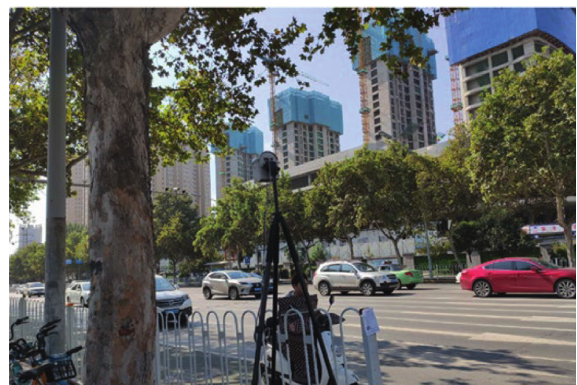
Figure 5: The radar survey at the intersection. This figure was taken at 34.2174 ° N, 108.9125 ° E. The figure shows the radar erect at the south entrance of the intersection. When measuring, the radar speed measurement direction must be as parallel as possible to the driving direction of the vehicles and facing the front of the vehicles and must the same for the other three